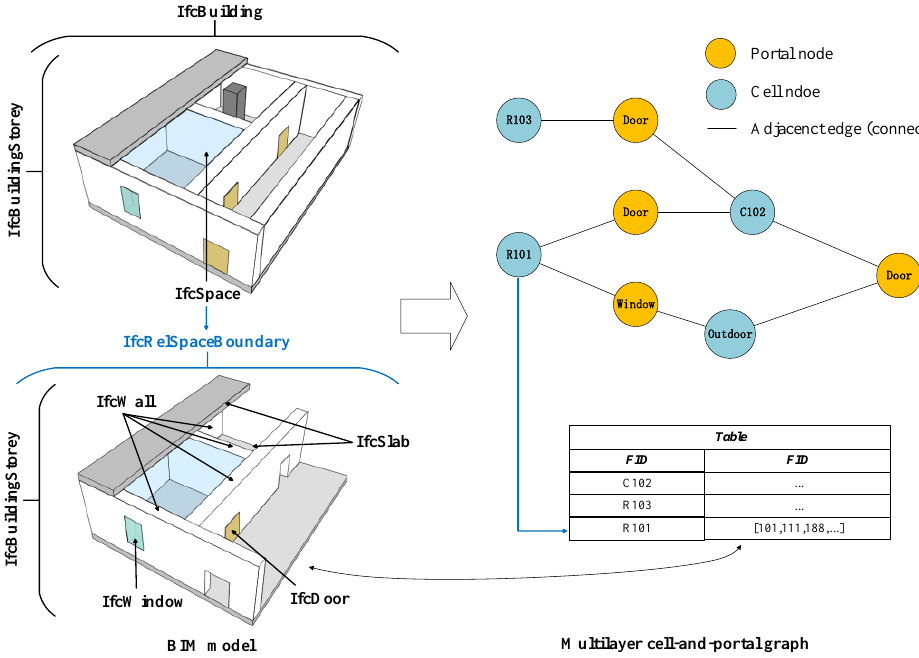
Figure 2. Multilayer cell-and portal graph.